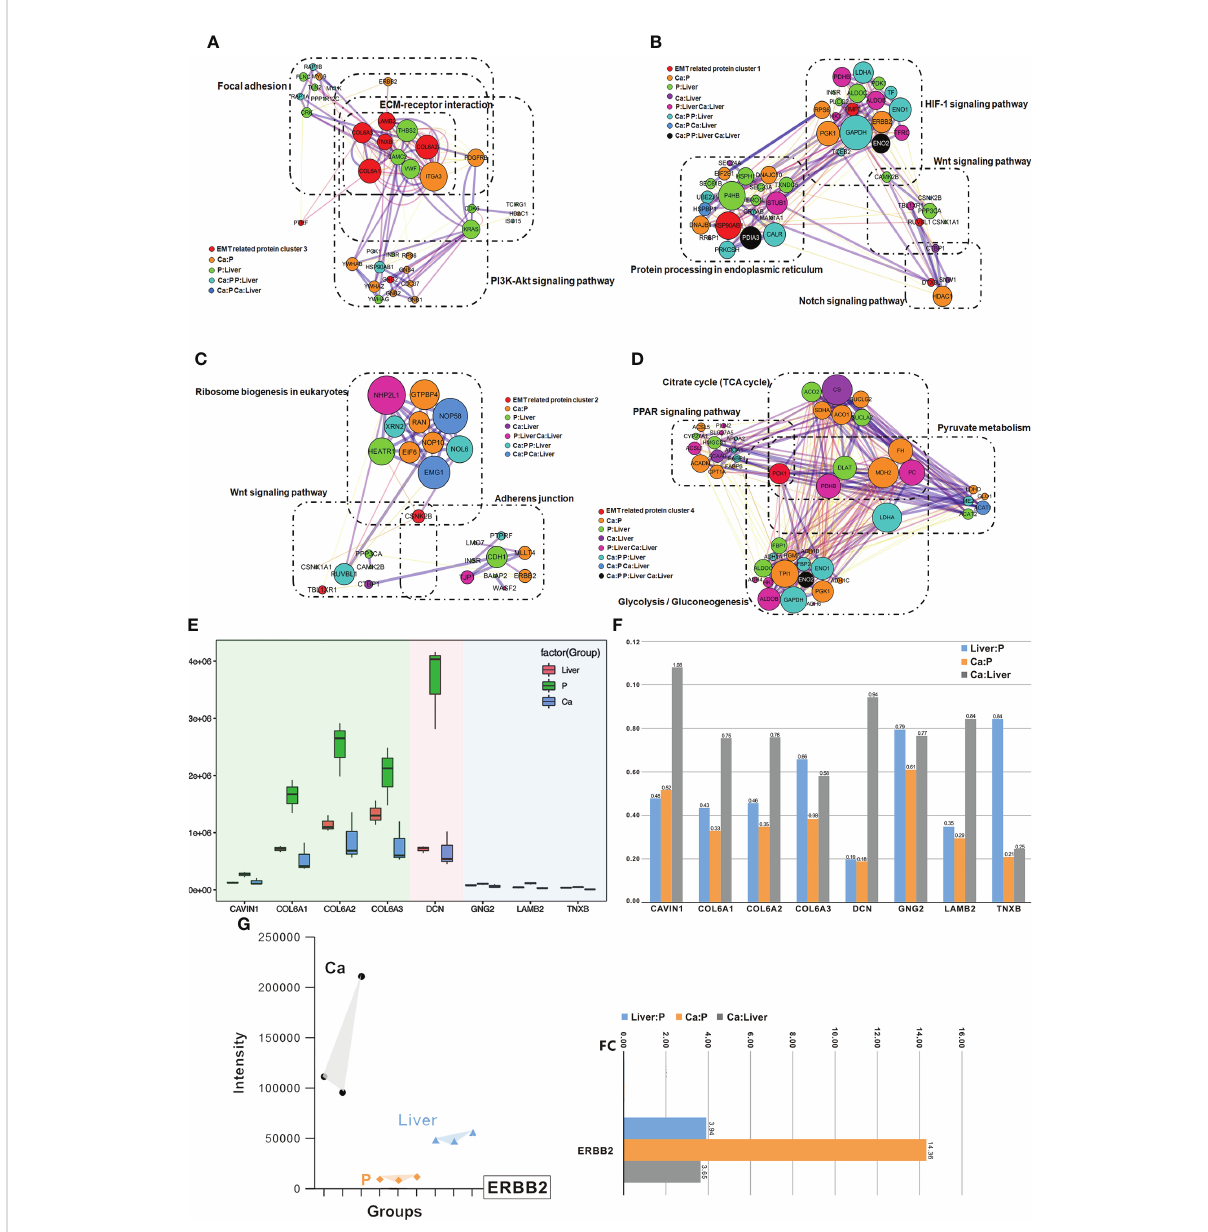
FIGURE 5 Clusters of EMT inferred by an integrated proteomic analysis. (A) All proteins in the pathway of differentially expressed proteins form the biggest EMT-related protein cluster. Interconnected network modules identi fi ed in some clusters. (B) All proteins in the pathway of differentially expressed proteins form EMT-related protein cluster (1). (C) All proteins in the pathway of differentially expressed proteins form EMT-related protein cluster (2). (D) All proteins in the pathway of differentially expressed proteins (PCK1) form EMT-related protein cluster (2), which majorly involved in glycolysis/gluconeogenesis, citrate cycle (TCA cycle), pyruvate metabolism and PPAR signaling pathway. (E) PRM analysis of EMT- related protein in the validation cohort. (F) The change of target protein expression. (G) The change of ERBB2